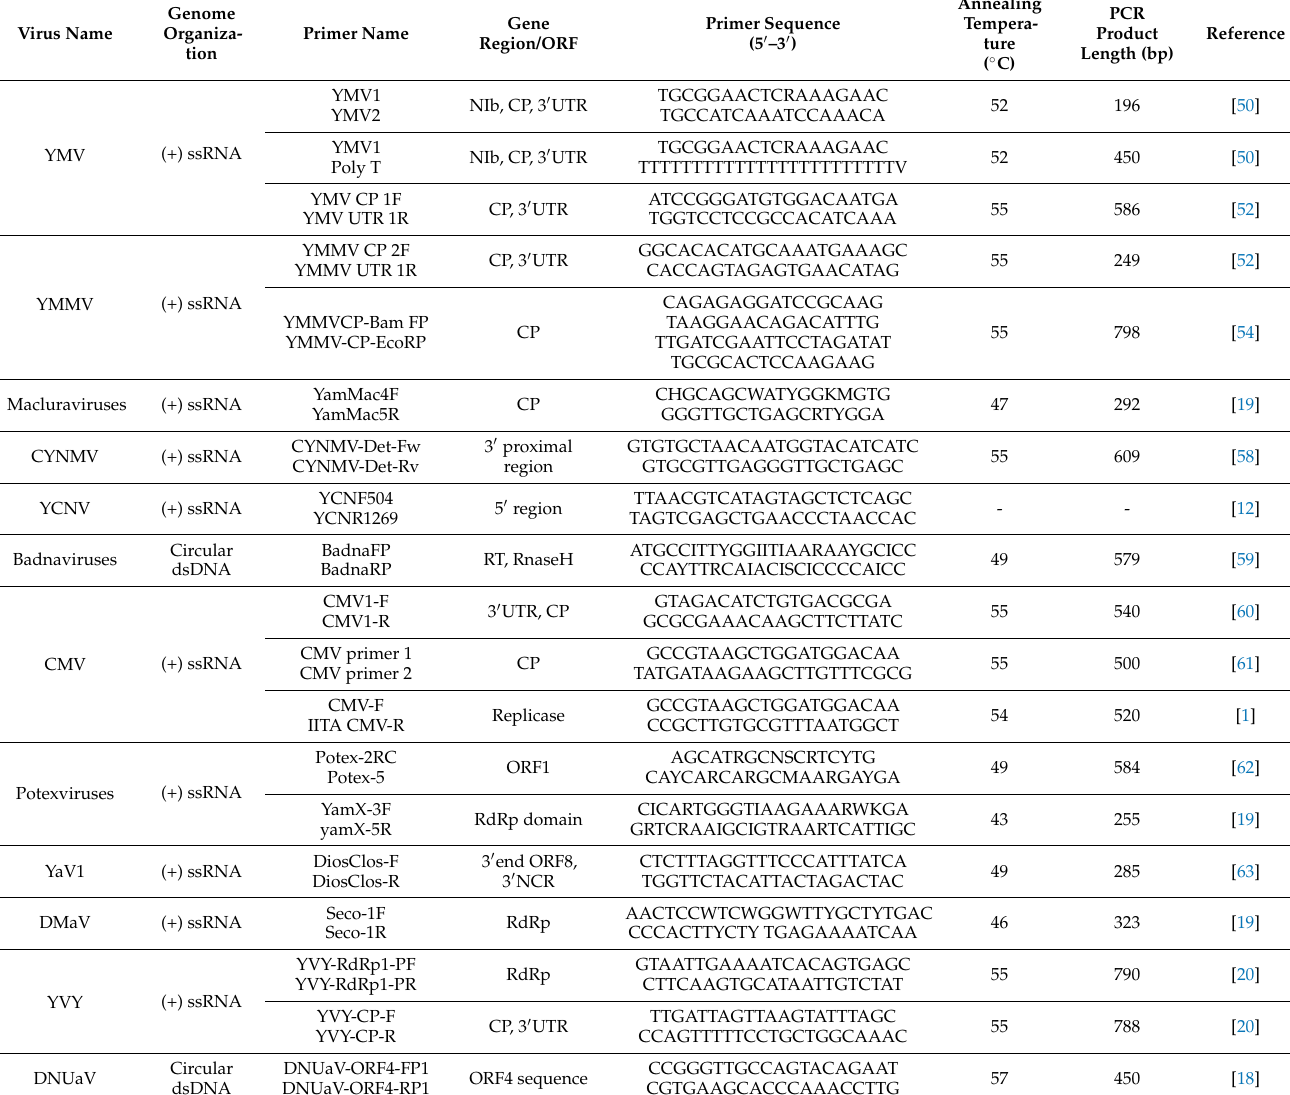
Table 1. List of yam viruses, their classification, and PCR primers available for their